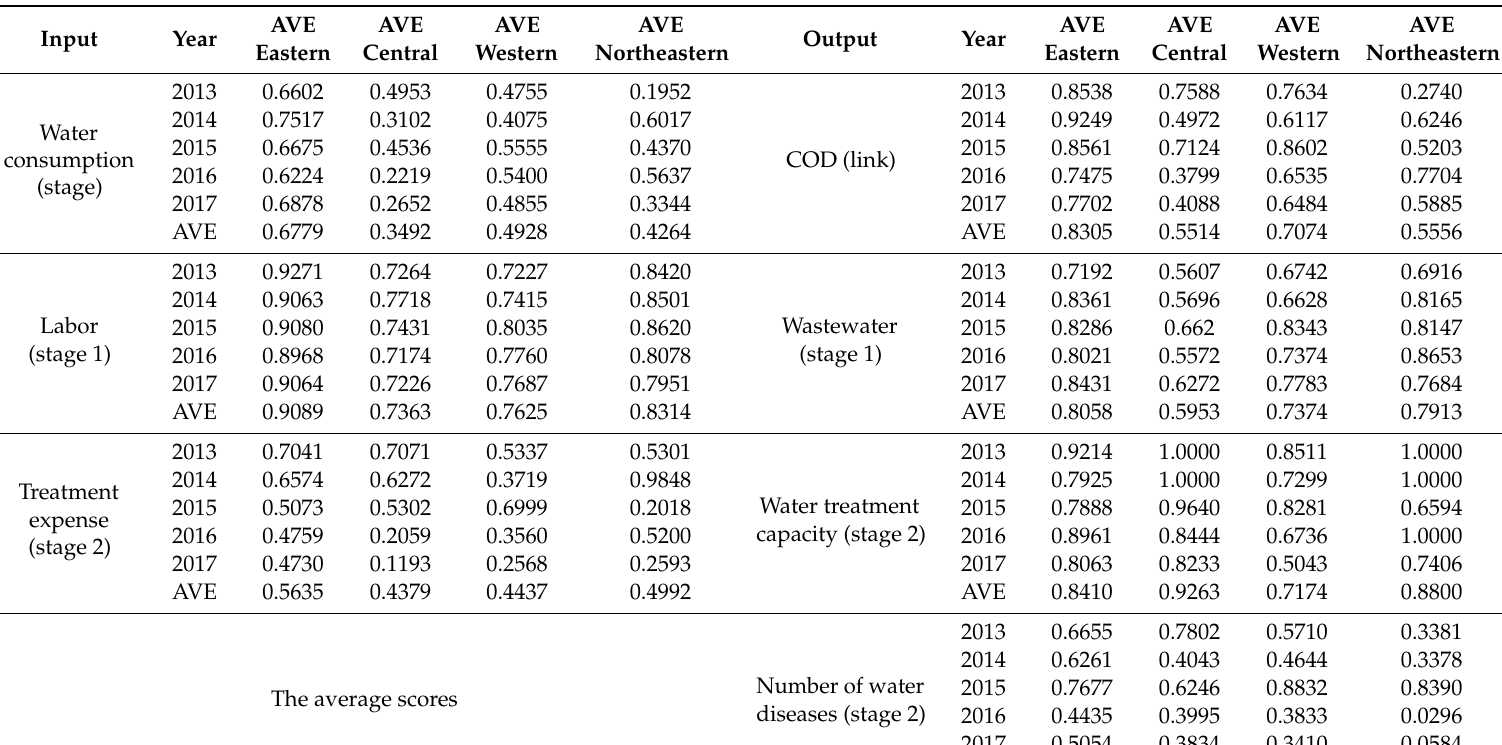
Table 4. The average scores of input and output variables in Stage 1 and Stage 2 from